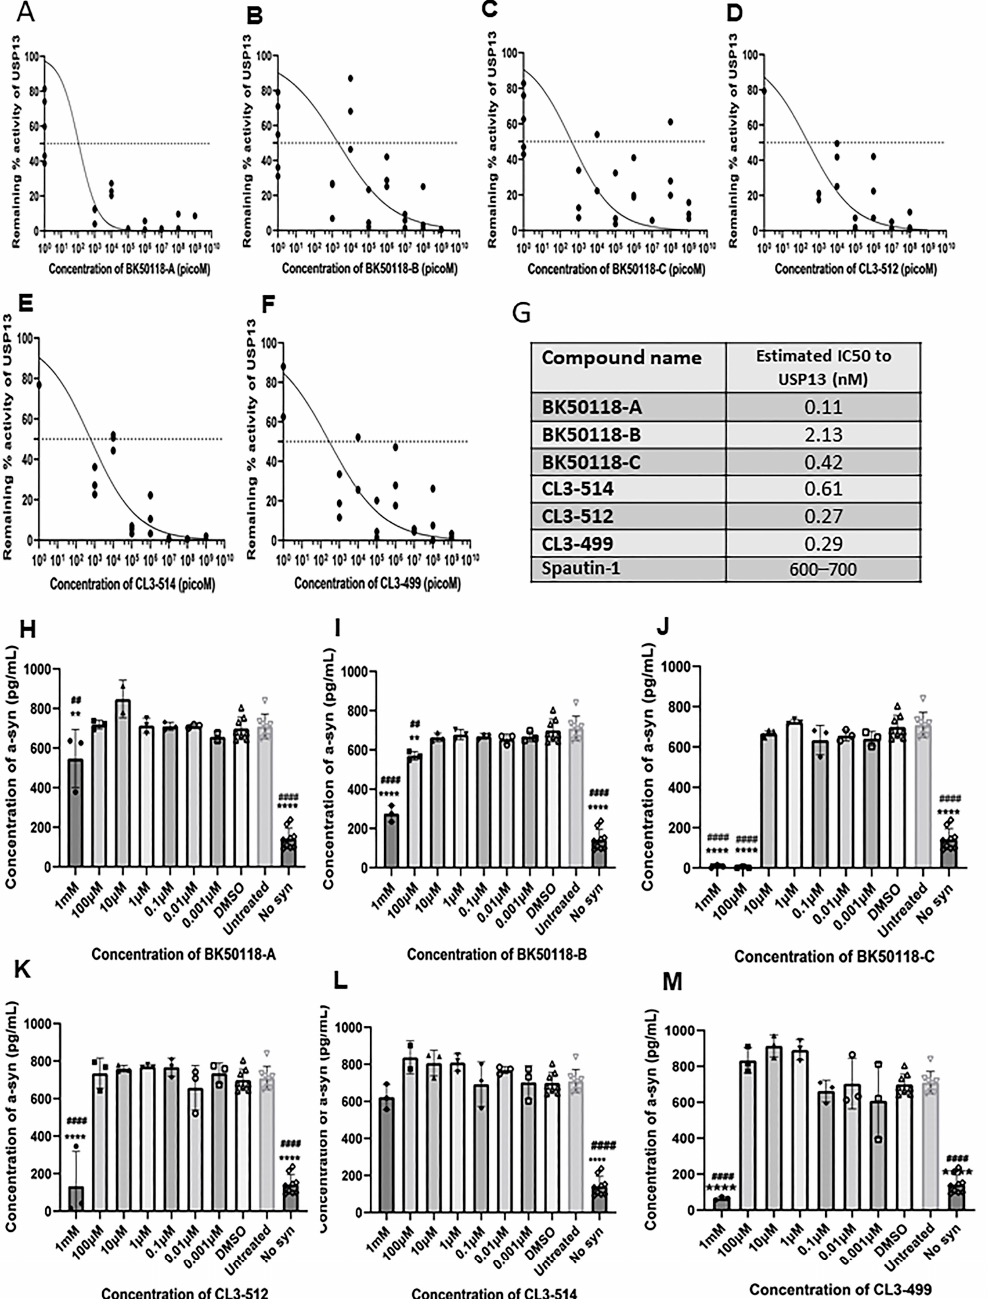
Figure 3. The effects of the novel small molecule compounds on the USP13 activities and alpha-synuclein in vitro. The SH-SY5Y cells were transinfected with human alpha-synuclein plasmid. Cells were treated with a serial of concentrations of each individual compound for 5 h. ELISA was performed for ( A – F ) USP13, and ( G ) estimated IC50 to USP13 was calculated. ELISA for ( H – M ) alpha-synuclein. ** p < 0.01, **** p < 0.0001 to DMSO group, ## p < 0.01, #### p < 0.0001 to untreated group; ordinary one-way ANOVA. N = 3–9 per treatment